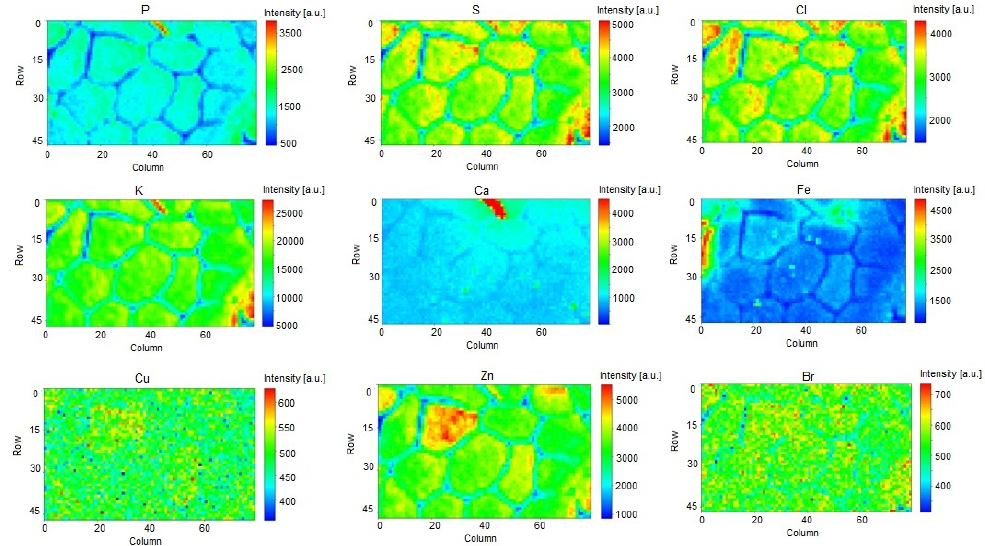
Figure 1. Element distribution maps for selected elements for a sample from the reference group.